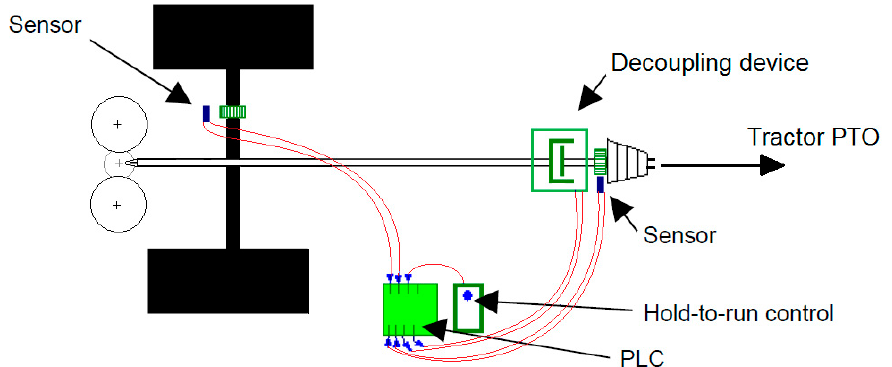
Figure 3. Scheme of the system (modified from [10]).